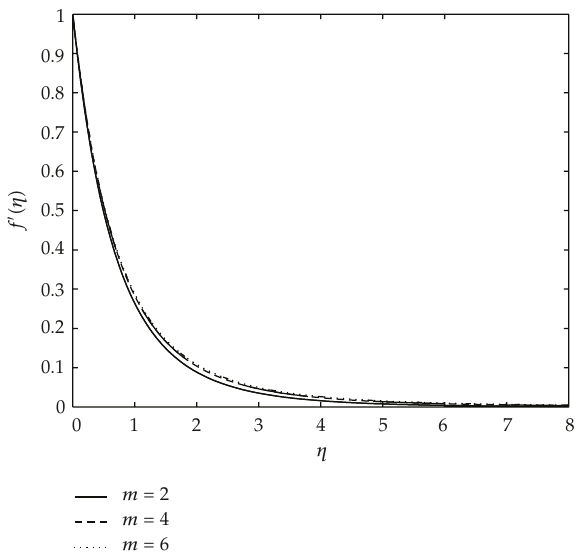
Figure 4: The variation axial velocity distributions with increasing values of m with M (cid:5) 1, Pr (cid:5) 0 . 72, β 1 (cid:5) 0 . 1, β 2 (cid:5) 0 . 1, and S (cid:5) 0 . 8